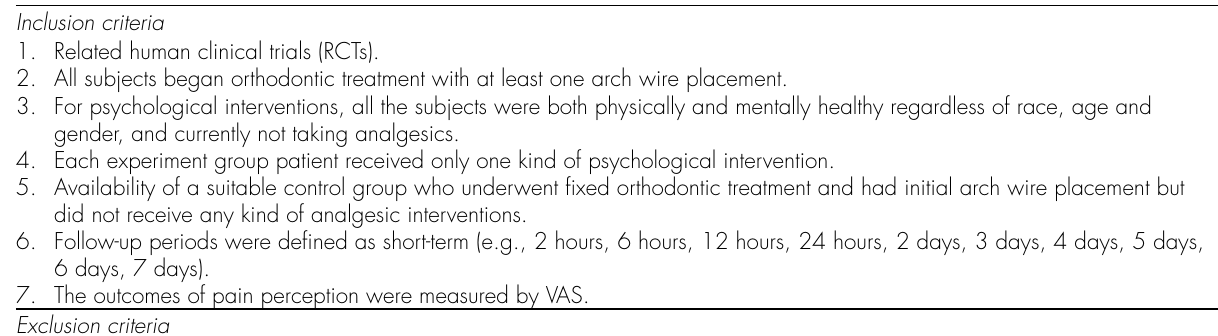
Table I. Embase search